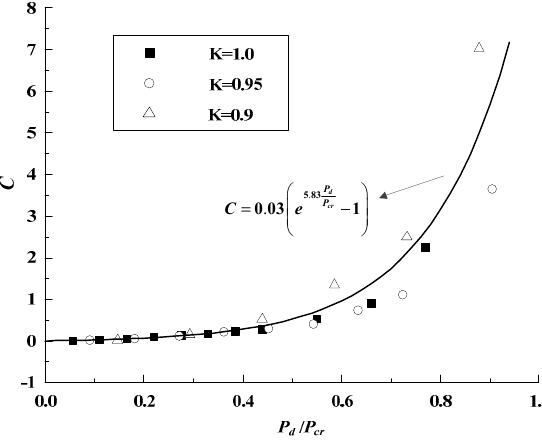
Figure 16. The relationship between C and P d / P cr.